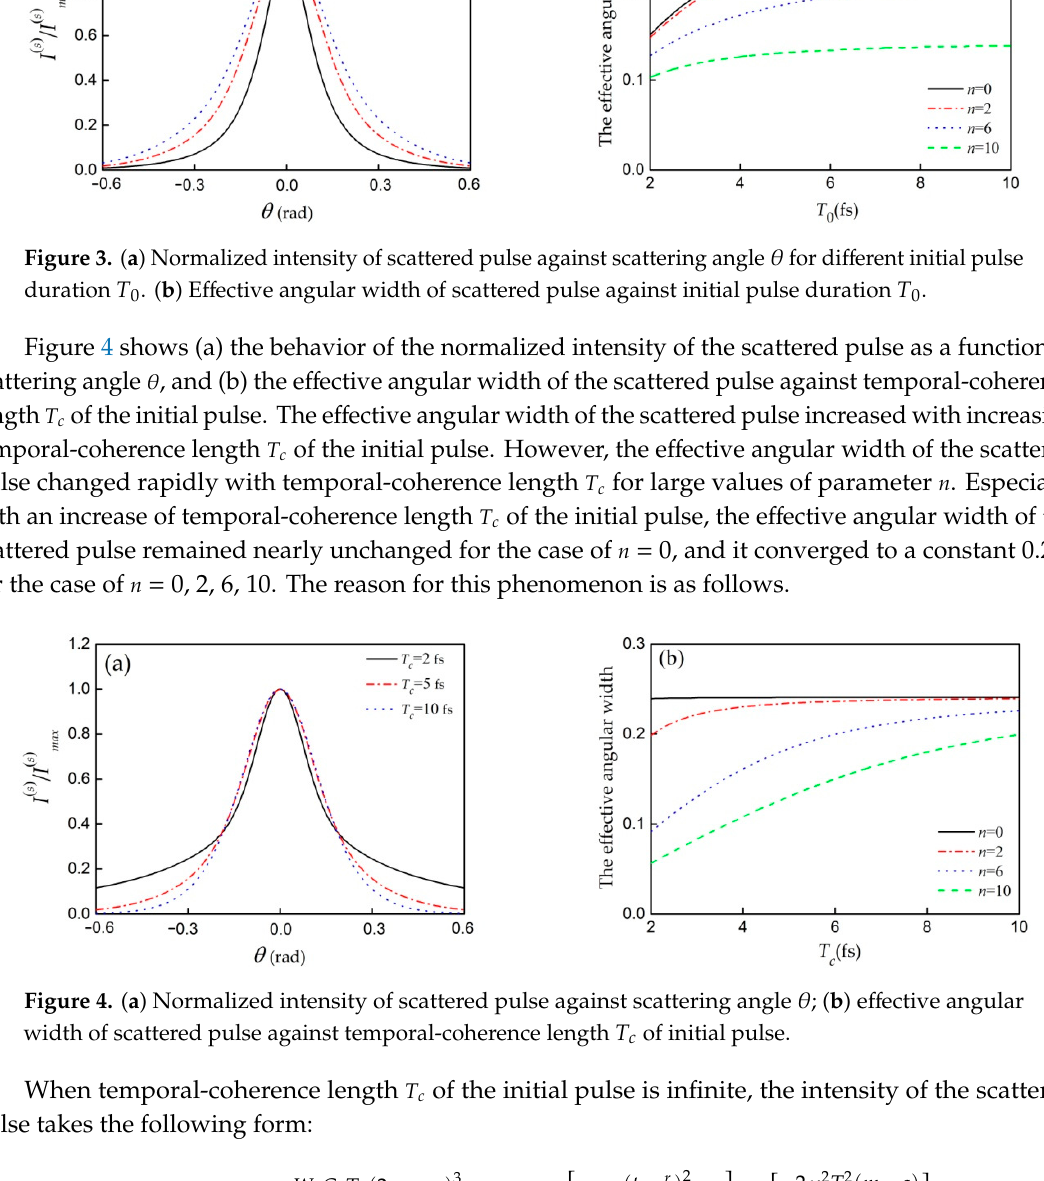
Figure 3. ( a ) Normalized intensity of scattered pulse against scattering angle θ for different initial pulse duration T 0 . ( b ) Effective angular width of scattered pulse against initial pulse duration T 0 .